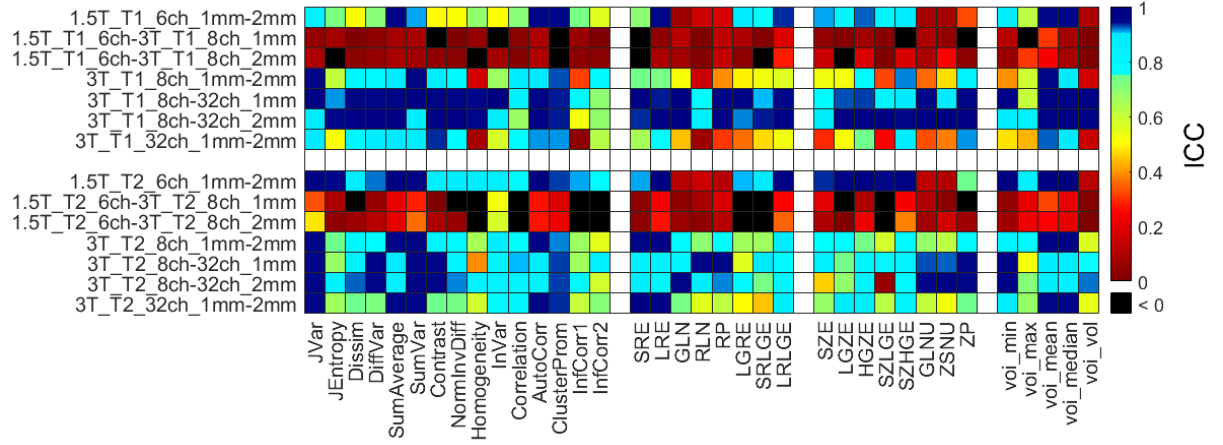
Figure 8. Heatmap of the ICCs calculated for the 14 different comparisons and computed RI. Black squares correspond to ICCs with a value below zero, indicating high error rates between the measurements. ICC = interclass correlation coefficient.